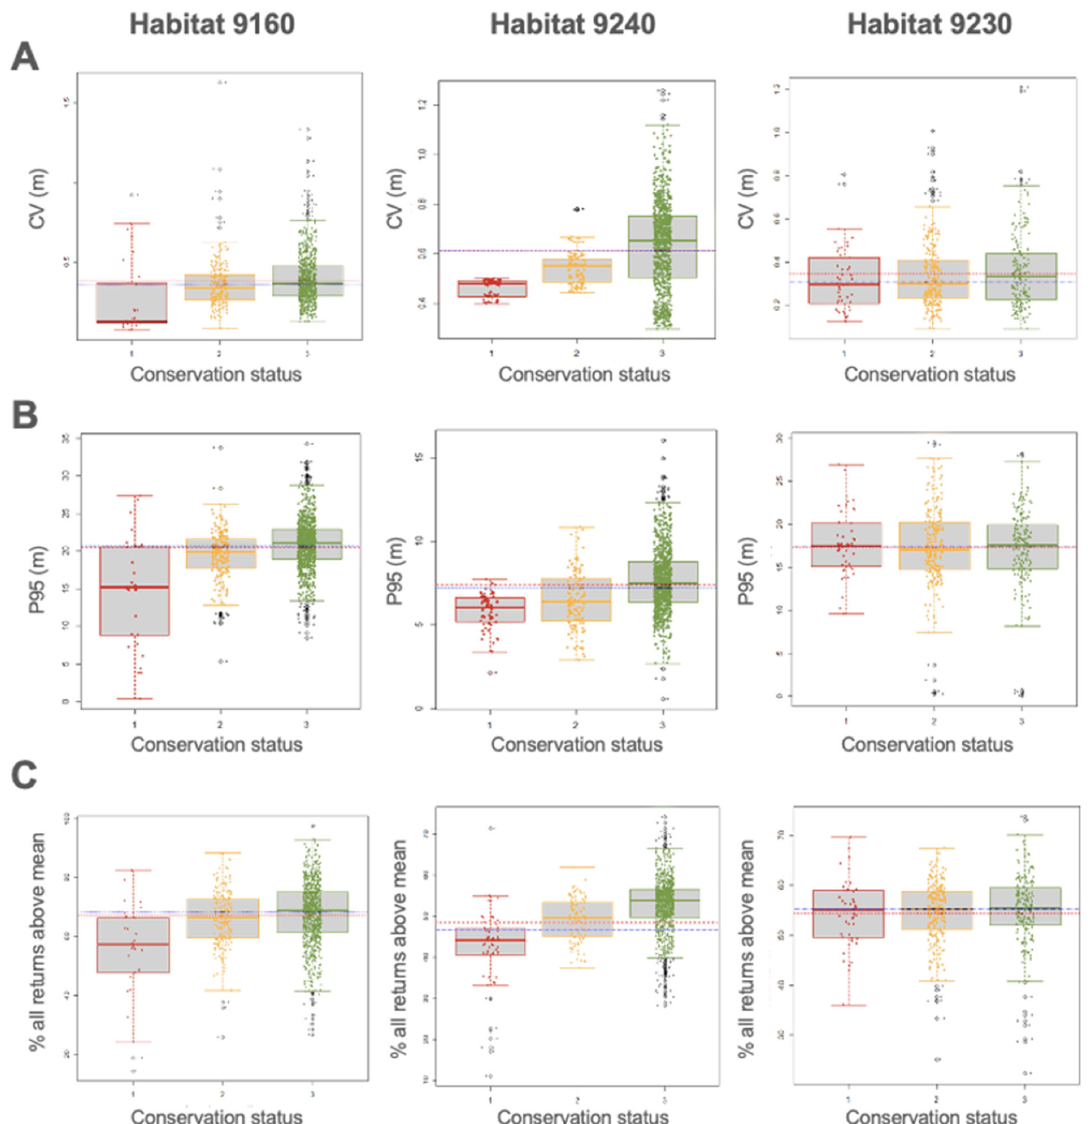
Figure 4. Box plot diagrams of the variables ( A ) CV (m), ( B ) P95 (m), and ( C ) % of all returns above the mean between the different conservation statuses for habitats 9160, 9240, and 9230. The dashed blue line denotes the median, and the dotted red line is the average mean. 1: unfavorable ‐ bad status (red); 2: unfavorable ‐ inappropriate status (yellow); 3: favorable status (green). Additionally, 9160 is Quercus robur habitat, 9230 is Quercus pyrenaica habitat, and 9240 is Quercus faginea habitat .